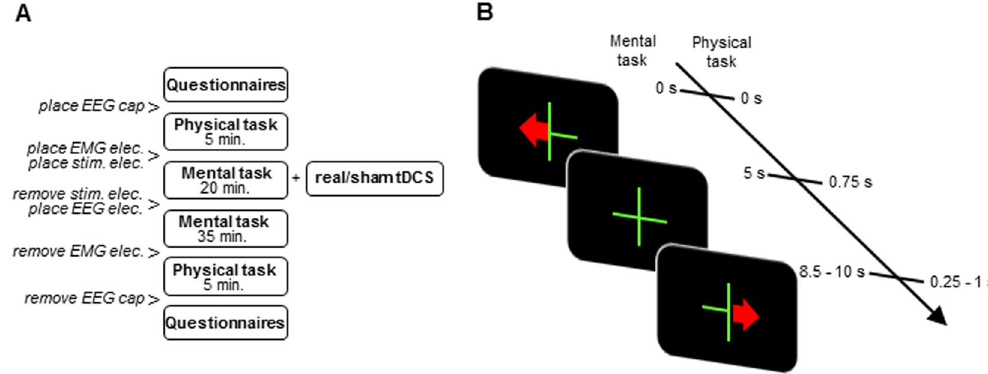
Figure 1. Schematic representation of the experimental procedure. ( A ) Illustrated is one of two sessions composing the within-subject sham-controlled design. Each session started with questionnaires followed by the physical motor task. After the physical motor task electrodes were placed over the Opponens Pollicis and First Dorsal Interossei of each hand to record surface EMG. Next stimulation was delivered, while participants performed the mental MI task. We administered either bilateral transcranial direct current stimulation (tDCS) or sham stimulation for 20 min. above the sensorimotor areas. After stimulation the stimulation electrodes were removed and replaced by EEG electrodes. Then the mental MI task was continued and MI-induced EEG activity was recorded. While participants performed the mental MI task, during and after stimulation, EMG activity was recorded. Following the MI task EMG electrodes were removed and the session ended with the physical motor task and questionnaires. ( B ) Trial layout for the mental MI task and the physical motor task. The presented stimuli (green fixation cross, red arrow pointing to the left or right) were identical for the mental MI and the physical motor task, while the timing of the stimulus presentation differed between the two tasks. The mental MI task followed the timing indicated on the left side of the time line and the physical motor task followed the timing indicated on the right side of the time line. During the physical motor task participants were instructed to place their index, middle, ring and little finger above predefined keys on the keyboard. Each trial started with the display of the red arrow pointing to the left or right, whereby the direction of the arrow indicated the hand to be used for the sequential finger-tapping task. Participants were instructed to initiate and execute the sequence as fast and accurate as possible. During the mental MI task participants were instructed to imagine the sequential finger-tapping task kinesthetically from the first person perspective for 5 s. Similar to the physical motor task each trial was initiated by the appearance of the red arrow and its direction indicated the hand to be used for the MI